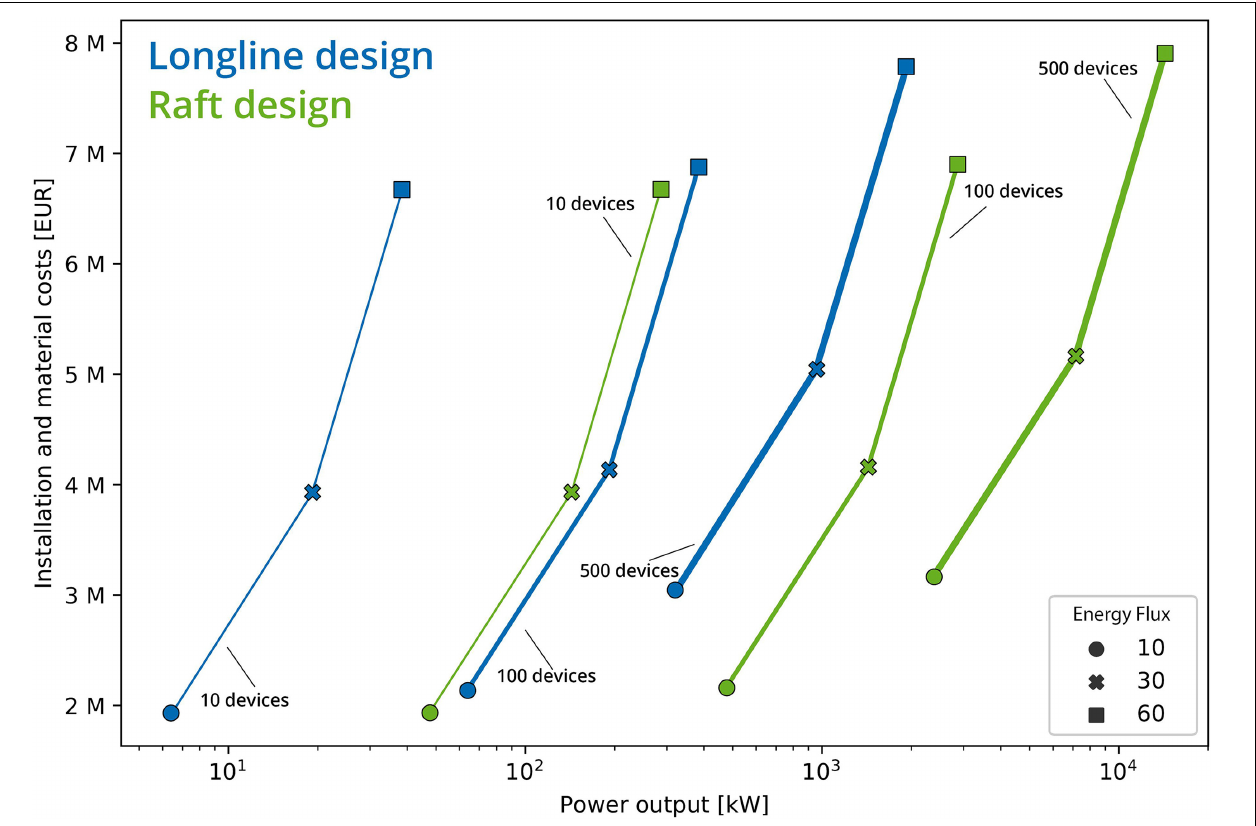
FIGURE 4 | Installation costs per kilowatt values, depending on chosen primary capture system design (longline or raft) and number of installed devices (10, 100, or 500) represented through colours. Symbols show sensitivity of results for different energy flux assumptions (10, 30, and 60 kW/m). Installation costs are based on mean values of cable distances from the sensitivity analysis + assumption for deployment with vessel of 46,000 EUR. Power output categories are based on Babarit